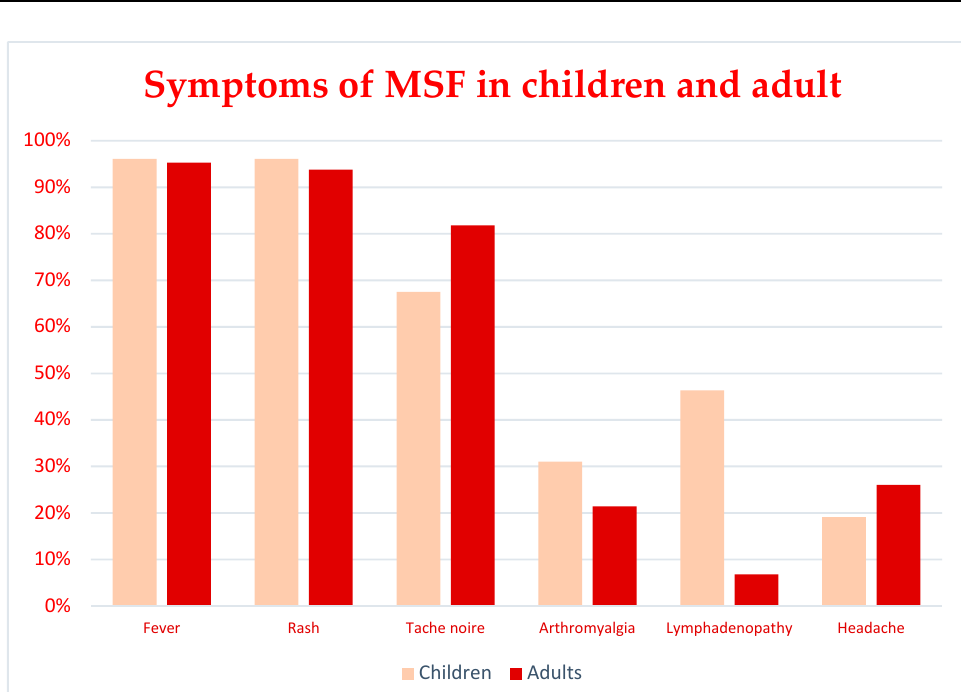
Figure 3. Comparison between main symptoms of MSF in children and adults.